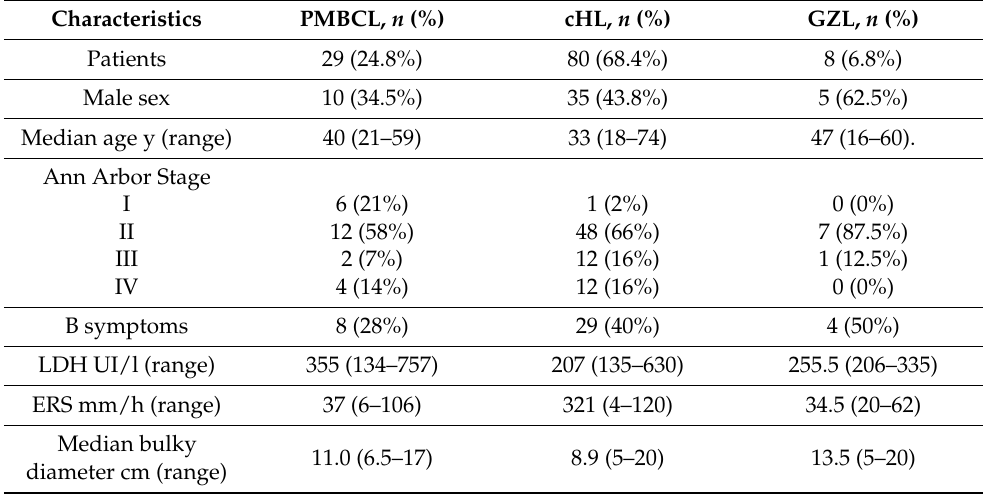
Table 2. Summary of the study population.